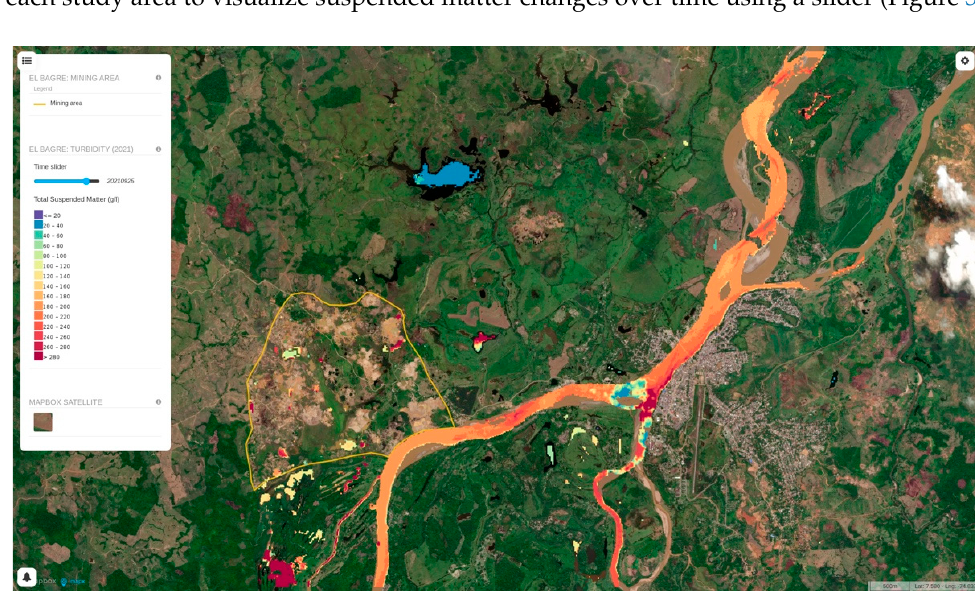
Figure 2. Water classification results over the period 1 January 2021/31 October 2021 around the town of El Bagre showing variability in Sentinel-2 image quality. Results are classified as follows: blue = water; green = not water, and white = pixel removed by the clean mask for the analysis.